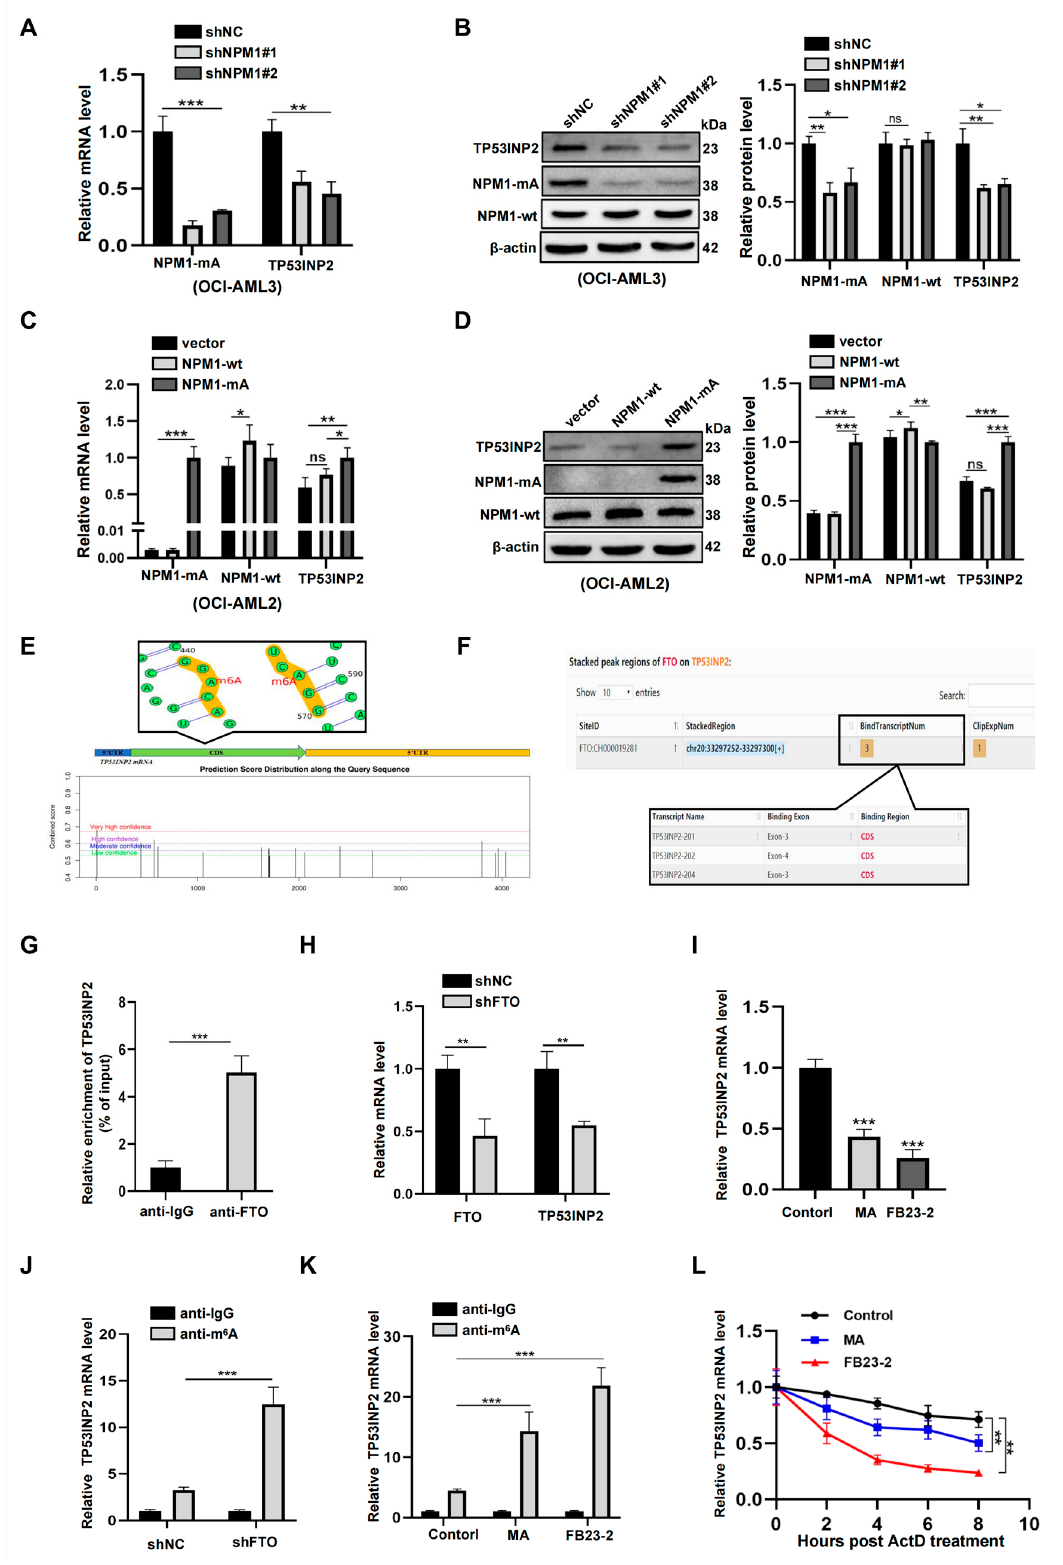
Figure 3. FTO-mediated m 6 A modification upregulates TP53INP2 expression. ( A , C ) qRT-PCR analysis of TP53INP2 , NPM1-wt , and NPM1 - mA mRNA levels in NPM1-mA-silenced OCI-AML3 and NPM1-mA-enforced OCI-AML2 cells. ( B , D ) Western blot analysis of TP53INP2, NPM1-wt,